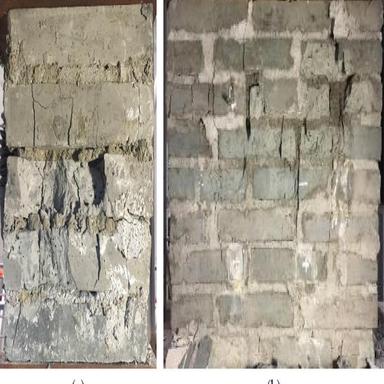
Failure patterns for the compressive tests: (a) prism and (b) panel.